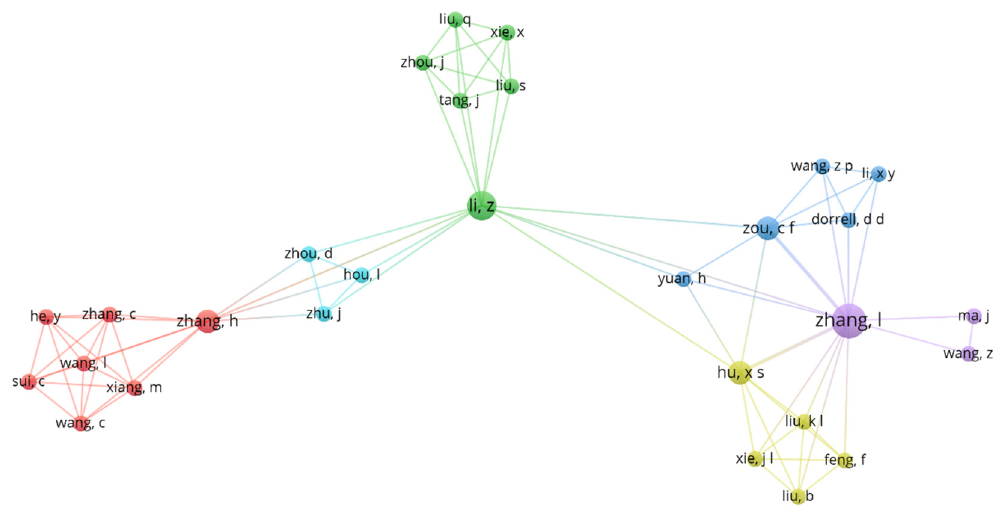
Figure 3. Most crucial authors in the literature review.